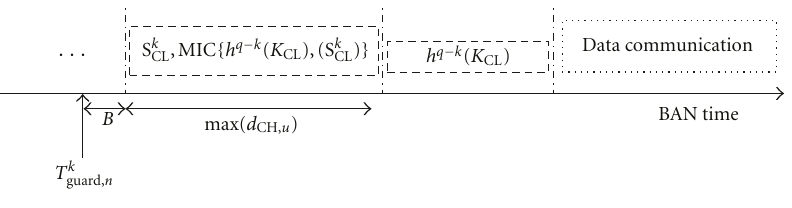
Figure 2: Usage of μ